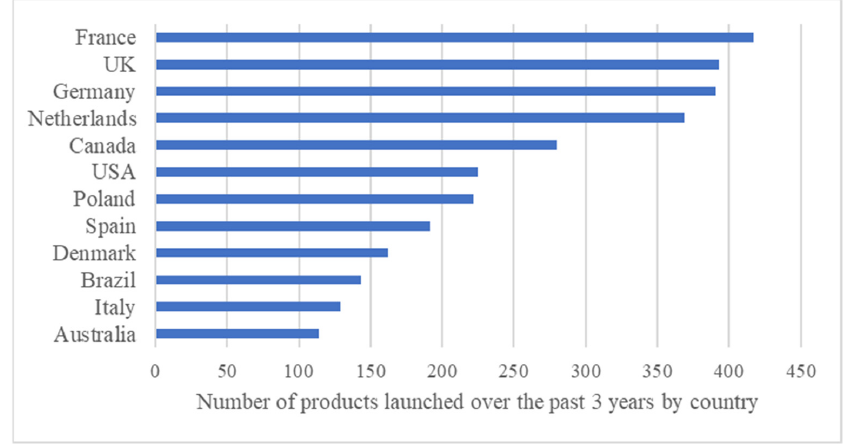
Figure 2. Twelve most active countries in PBMA launches over the past three years (2019–2021). Note: Each bar represents the total number of PBMAs’ launches between January 2019 and December 2021.